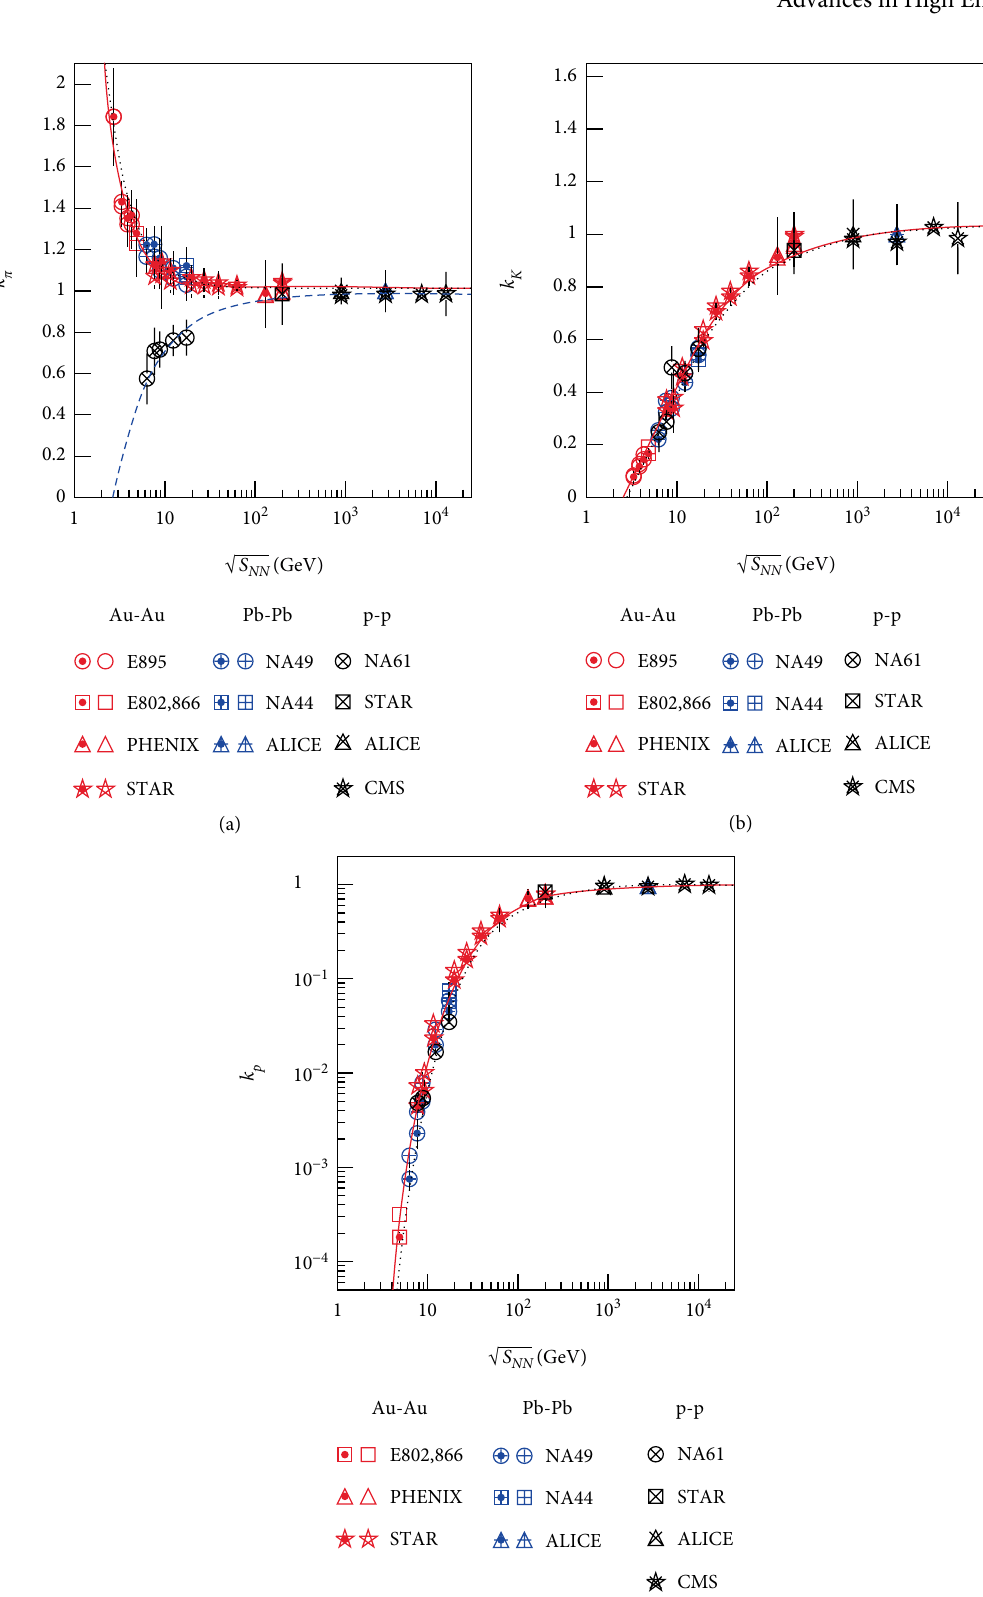
, (b) , and (c) , of negatively to positively charged particles produced in mid-(pseudo)rapidity interval in 𝑘 𝜋 𝑘 𝐾 𝑘 𝑝 collisions, as well as in forward rapidity region in INEL 𝑝𝑝 , or the symbols with and without , denote the yield ratios quoted in literature (see Table ∙ ∙ + , or the symbols with and , denote the yield ratios corrected to the primary ∙ ∙ + dependent (see Equations (7)–(13) for √𝑠 𝑁𝑁 𝑘 𝑗